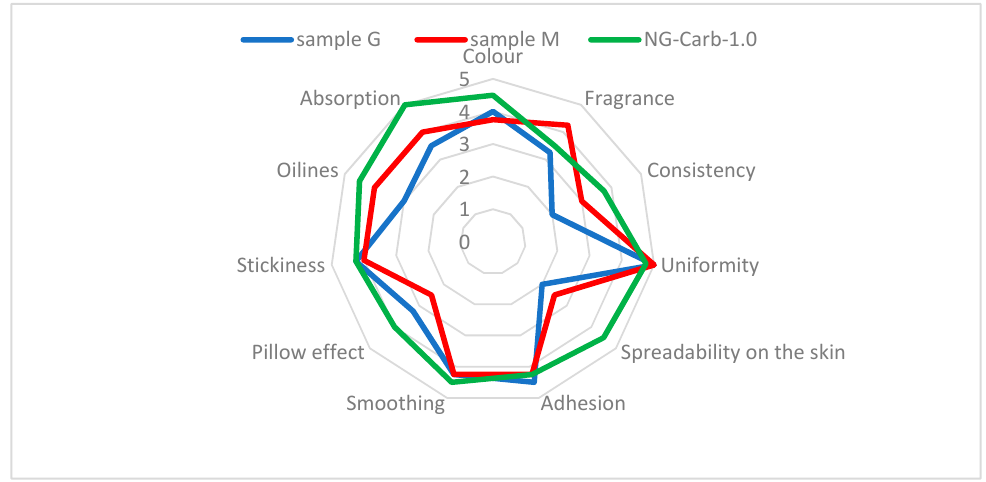
Figure 6. Results of the organoleptic evaluation of sample G, M and nanoemulgel (NG-Carb-1.0).